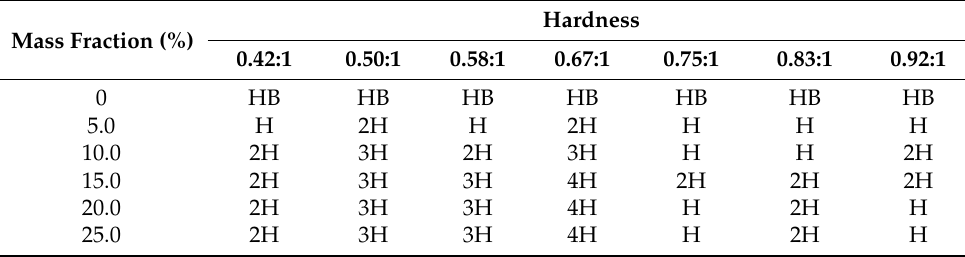
Table 4. Effect of microcapsule concentration and core-shell ratio on the hardness of paint films. Mass Fraction